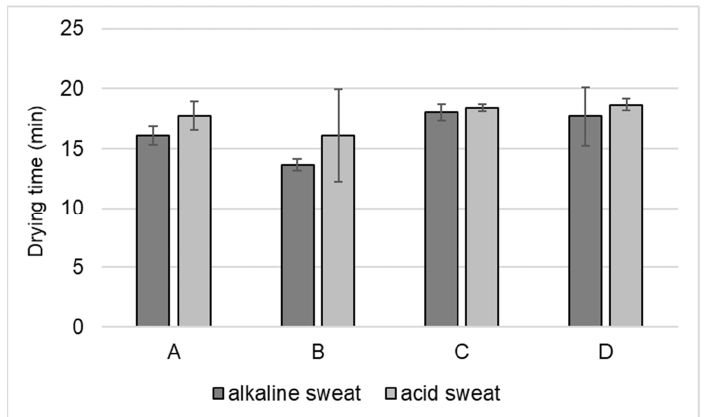
Figure 4. Drying time (100%) of the fabrics with alkaline and acid artificial perspiration.